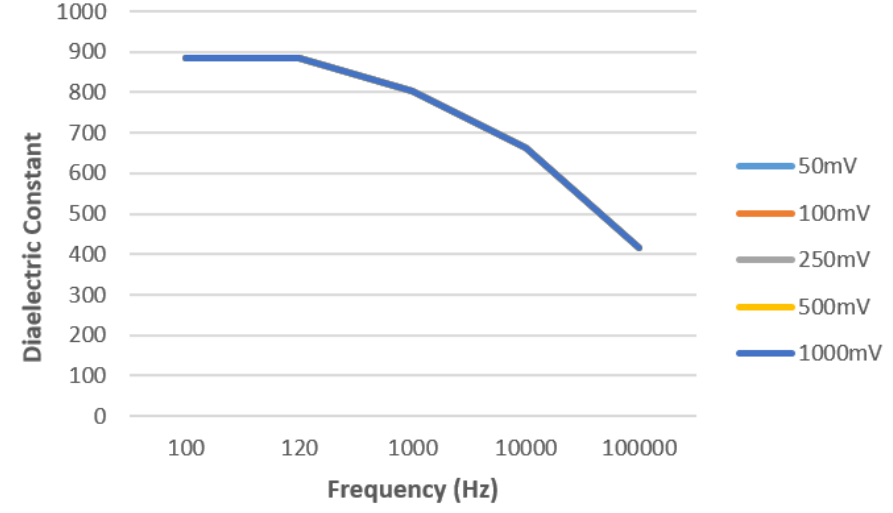
Figure 11. The dielectric constant for Cr-ZnSe crystal as the function of frequency at di ff erent bias voltages. The dielectric constant was almost the same for all